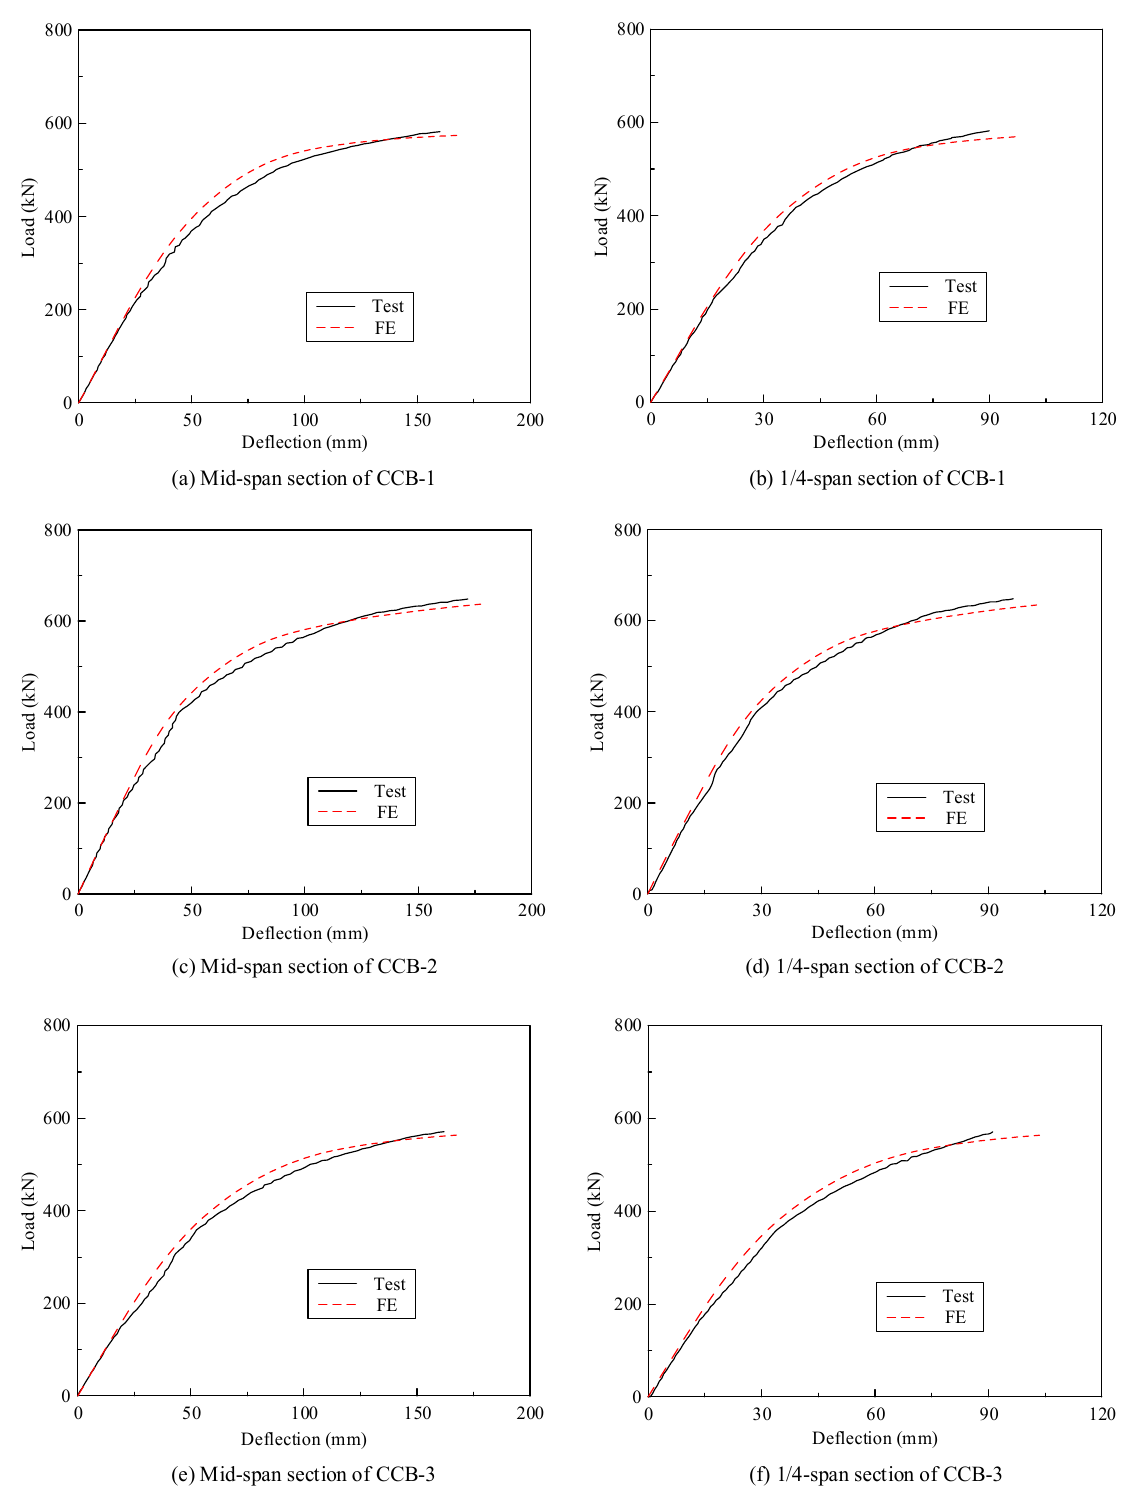
Figure 17. Comparison of the load–deflection curves from the test and numerical analyses.